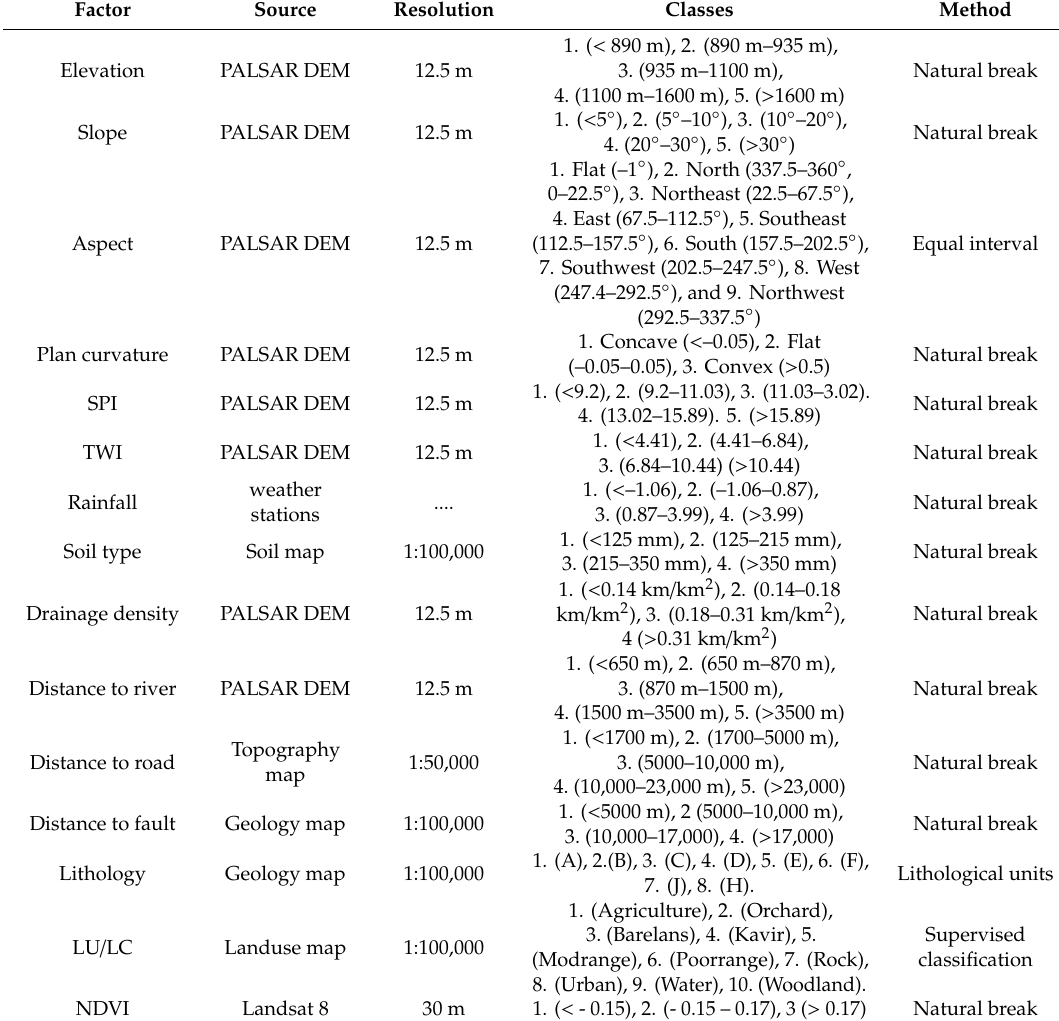
Table 1. Overview of factors used for gully erosion susceptibility